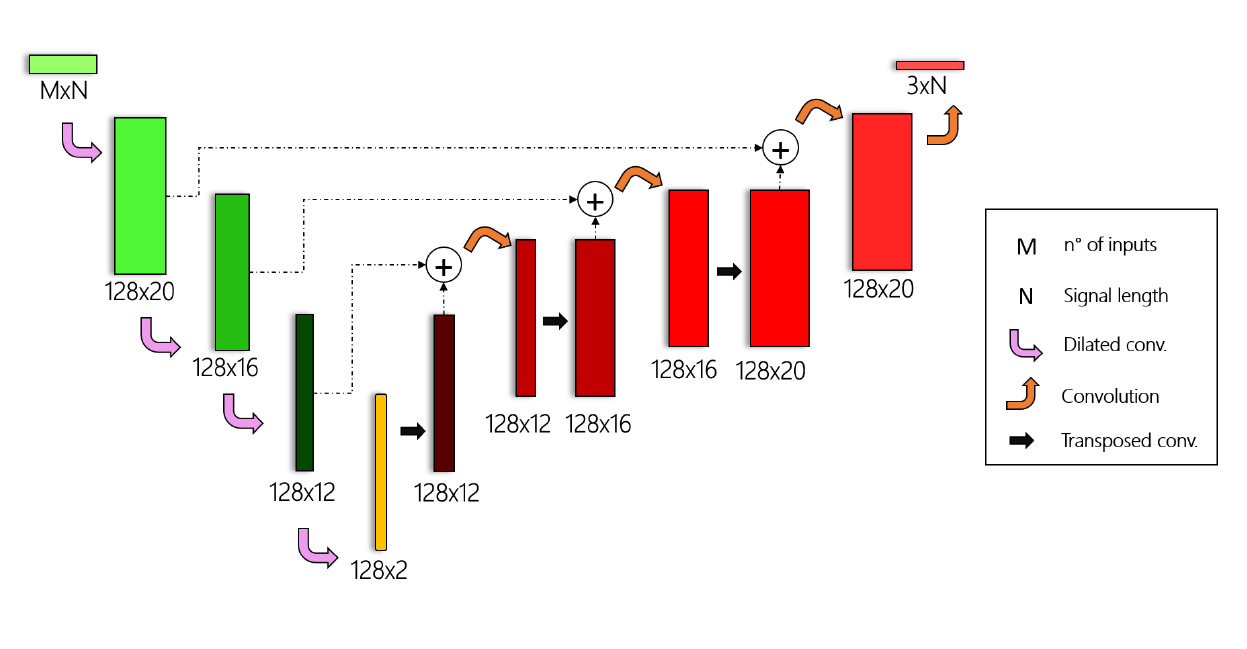
Figure 1. DANAE ++ architecture: the dilated convolutions (green blocks) represent the encoder part of the model, while the transposed and standard convolutions (red blocks) constitute the decoder